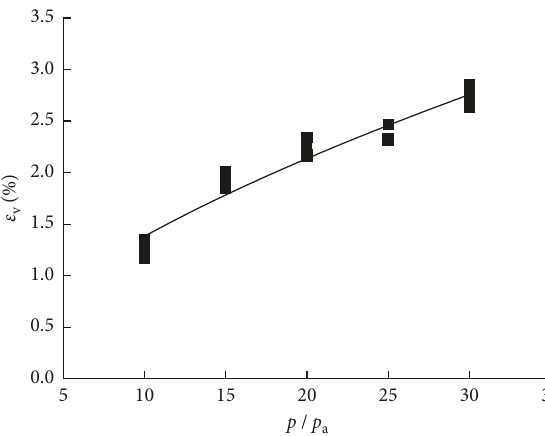
Figure 10: p / p a versus ε v curve (comparison of experimental and model